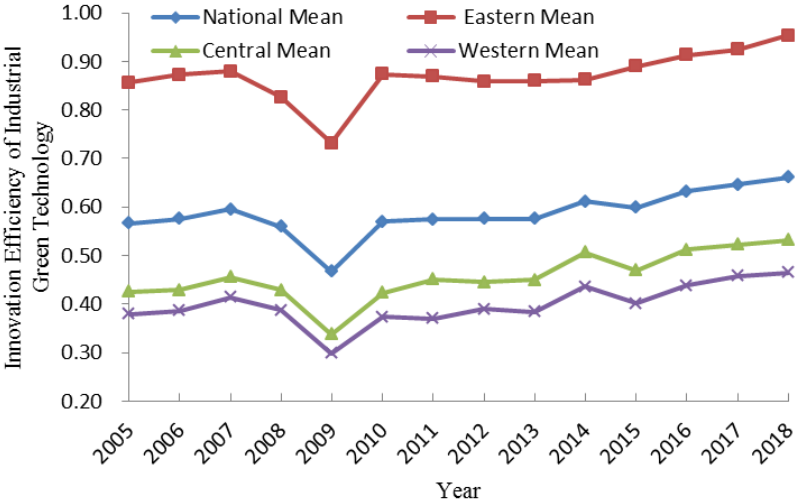
Figure 1. Industrial green technology innovation efficiency (GTIE) from 2005 to 2018. In terms of regions, industrial GTIE in the eastern region is the highest, showing a fluctuating upward trend from 2010 to 2018, with a gentle curve change and relatively stable development. Industrial GTIE in the central and western regions has always been lower than the national average. It began to rise gradually after the financial crisis, espe- cially after 2013. This change also caused the fluctuation of the national average to rise. The reason is that the environmental protection policies vigorously implemented in the central and western regions have effectively promoted the improvement of industrial green technology innovation efficiency, and the implementation of the “blue sky protec- tion plan” has further clarified that it is an inevitable way for gre en sustainable develop- ment to go hand in hand with the “high beauty” of the ecological environment and the “high quality” of economic development. With the implementation of China’s “Western Development Strategy”, “4 trillion plan” and “the belt and road initiative”, the investment in industrial infrastructure, traditional technological transformation and scientific and technological R&D in the central and western regions has been continuously increased, resulting in different degrees of improvement in economic benefits and innovation output of enterprises, and further promoting the industrial GTIE. In addition, the change rule of industrial GTIE in China’s eastern, central and western regions is similar to that of the whole country, but there is an obvious gap among the three regions, with the highest in